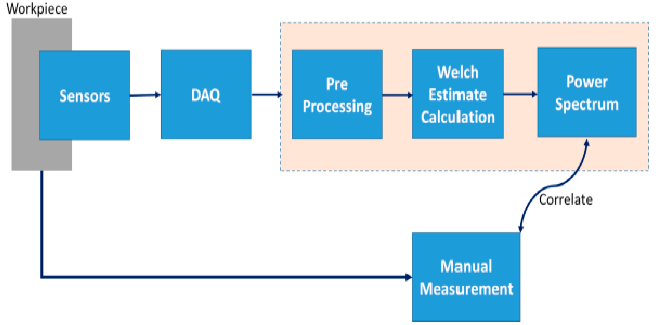
Figure 7. Trial and experimental setup. Figure 8. Process flow diagram.